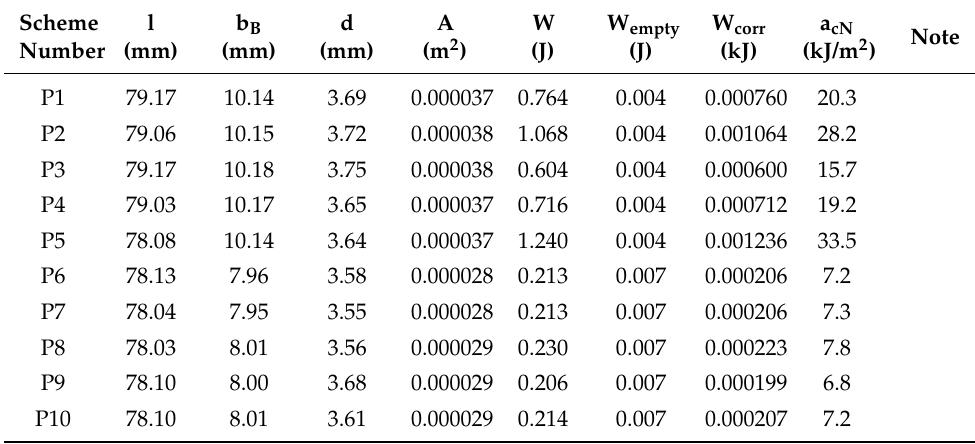
Table A8. Results of the notched impact tests and unnotched impact tests of